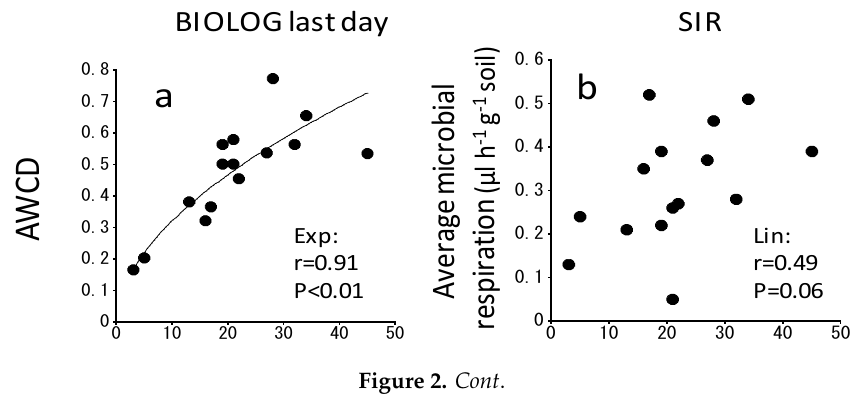
Figure 2. Cont . Figure 2. Cont